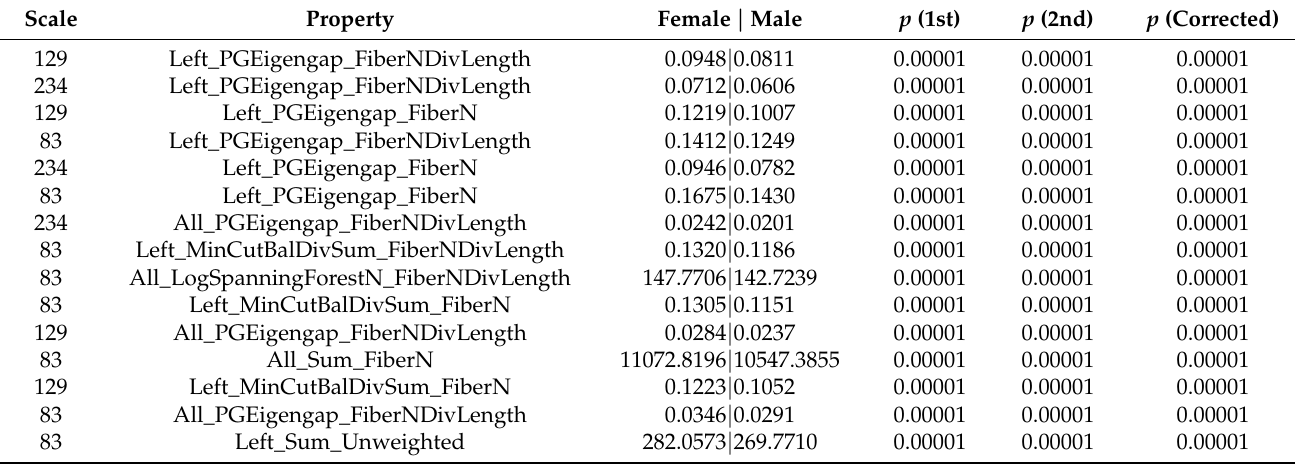
Table 1. The results and the statistical analysis of the graph-theoretical evaluation of the sex differences of the most significant sex differences in the 426-subject data set. The whole table can be found in the on-line supplementary Table S1. The first column gives the resolutions: the number of vertices in the whole graph. The second column describes the graph parameter computed: its syntactics is as follows: each parameter-name contains two separating “_” symbols that define three parts of the parameter-name. The first part describes the hemisphere or the whole connectome with the words Left, Right, or All. The second part describes the parameter computed, and the third part the weight function used. The third column contains values of the parameters, averaged to the sexes. The fourth column describes the p -values of the first round, the fifth column the p -values of the second round, and the sixth column the (very strict) Holm-Bonferroni correction of the p -value. Note that p -values, less than 0.00001 are rounded up to 0.00001 uniformly, since we did not want to use floating point numbers in the